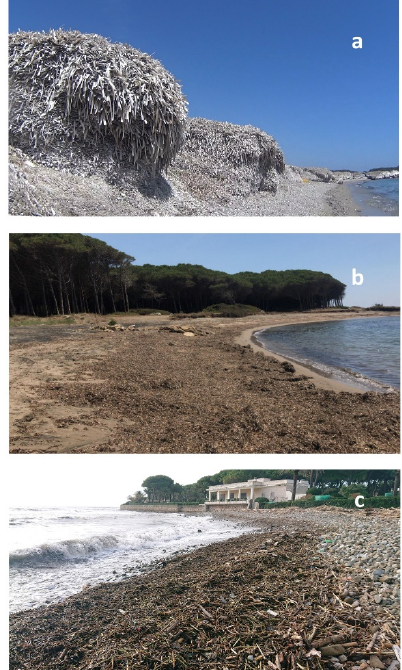
Figure 1. Seagrass beach cast classification adopted in BARGAIN project. ( a ) Type 1: well-structured deposits; ( b ) Type 2: unstructured deposits; ( c ) Type 3: unstructured mixed deposit.